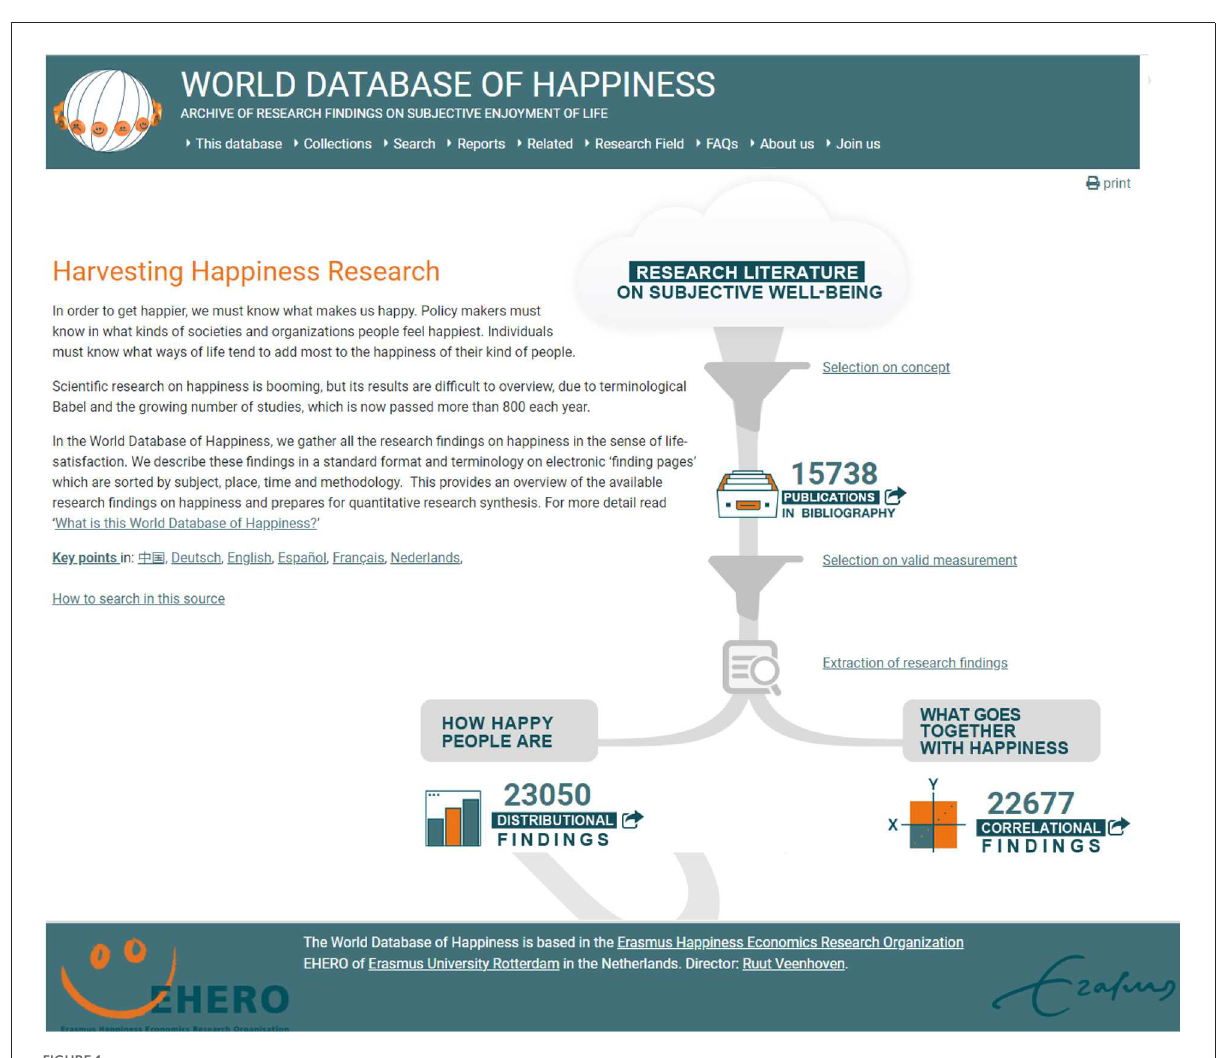
FIGURE1 Homepage of the world database of happiness. https://worlddatabaseofhappiness.eur.nl. Source: World Database of Happiness. Reproduced with permission.